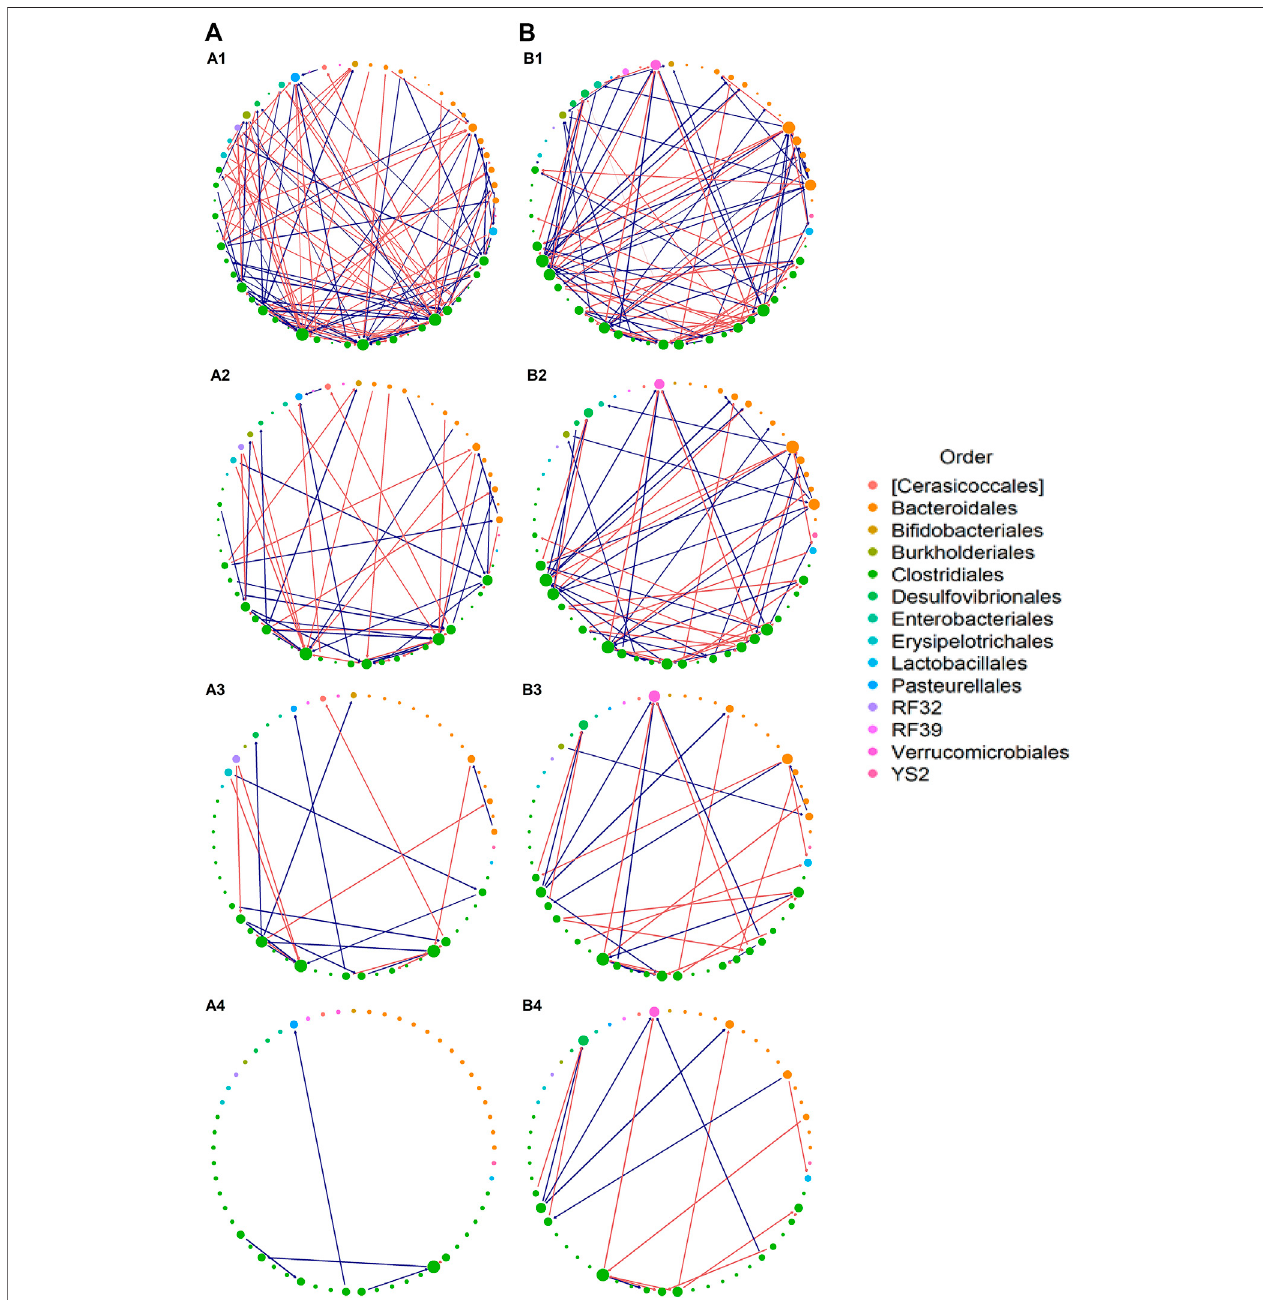
FIGURE 5 | Interaction network. Estimated interaction network for: (A) azithromycin (azm), and (B) control groups, displaying (1) all selected interactions, (2) interactions with | ^ B mj | ≥ 0 . 1, (3) interactions with | ^ B mj | ≥ 0 . 25 , and (4) interactions with | ^ B mj | ≥ 0 . 5. Each node represents a taxon at the genus level, the size of which shows thedegree ofthattaxaand thecolorofwhichshowsthephylogeneticOrderlevelforeach taxon.Each edgewitharrow representsaninteractioneffect,thewidth of which represents the absolute effect size on a log 10 scale, with the color showing a positive (orange) or negative (blue) effect.